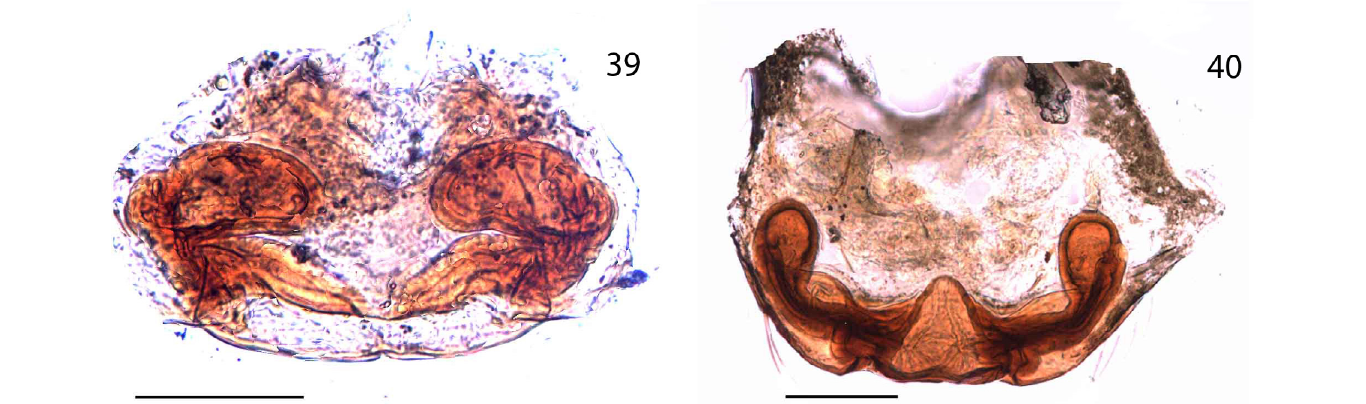
Figs 39-40. — 39 . Holmelgonia afromontana sp. nov. (♀, 227154). Epigyne, cleared, dorsal view. — 40 . Holmelgonia bosnasutus sp. nov. (♀, 227507). Epigyne, cleared, dorsal view. Scale bars = 0.1